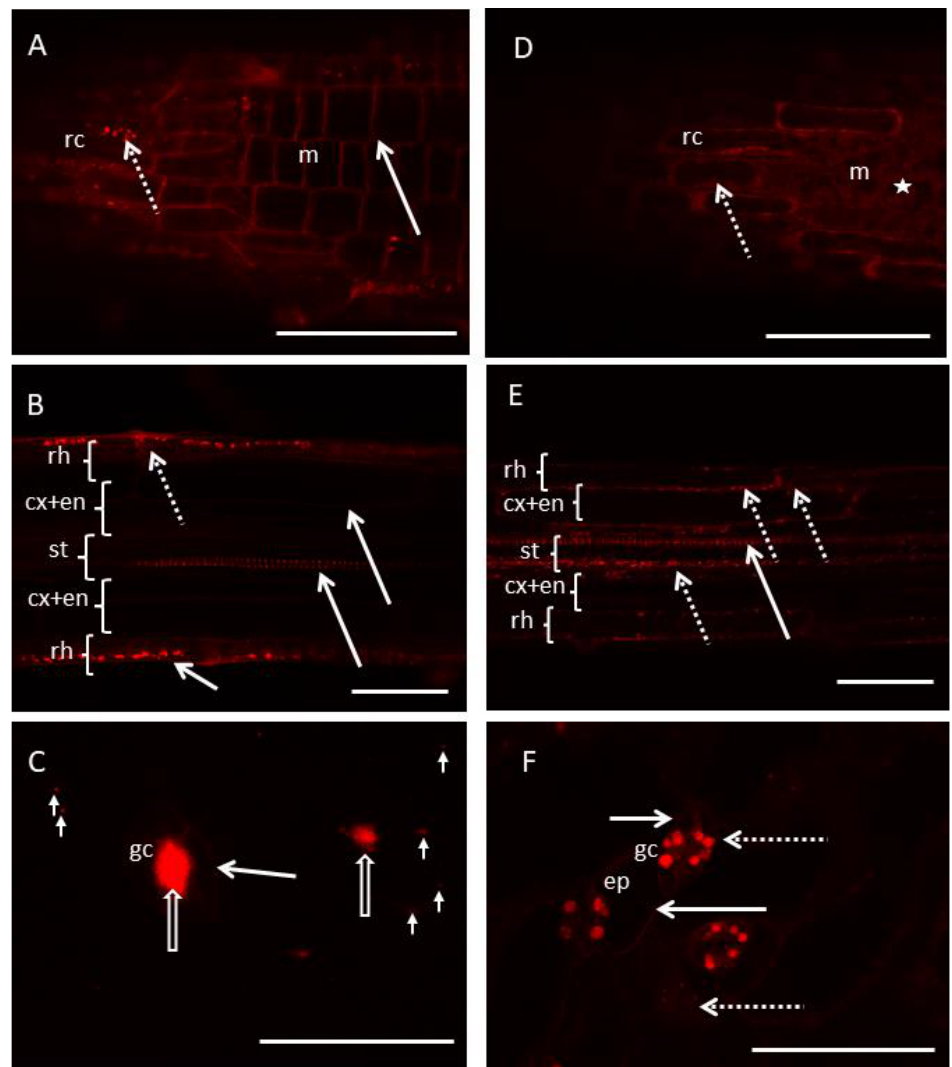
Figure 4. Cellular localization of RhB-polymers in a root ( A , B , D , E ) and cotyledon ( C , F ) of Arabidopsis thaliana . RhB-PchMA mostly visible in cell walls of root cap and root meristem cells (arrow) and in cell organelles of lateral root cap cells (dotted arrow) ( A ). Apoplastic (arrow) and cellular (dotted arrow) localization of RhB-PchMA observed in the root differentiation zone ( B ). RhB-PchMA present in cell walls of guard cells (arrow) and in the stomatal pore (empty arrow), and as spots on the surface of epidermis (arrowheads) ( C ). RhB-PHEMA visible in the cytoplasm of meristematic cells (asterisk) and root cap cells (dotted arrow) ( D ). In the root differentiation zone, RhB-PHEMA observed in cytoplasm (dotted arrows) of rhizodermis, cortex, endodermis, stele and in cell walls (arrow) of protoxylem ( E ). In a cotyledon epidermis, RhB-PHEMA visible in cytoplasm of pavement cells and in cytoplasm and chloroplasts of guard cells (dotted arrows) ( F ). It was also visible in cell walls of pavement cells and guard cells (arrows) ( F ). Images are Z-stack representations of 30–40 ( A – E ) or 2 ( F ) optical sections combined into one picture. Additionally, images A and D are longitudinal tangential sections, so root cap and meristematic cells are simultaneously visible. cx+en-cortex and endodermis, ep-pavement cells of epidermis, gc-guard cell, m-meristematic cells, rc-root cap, rh-rhizodermis, st-stele (pericycle, phloem, xylem and procambium). Scale bar: 50